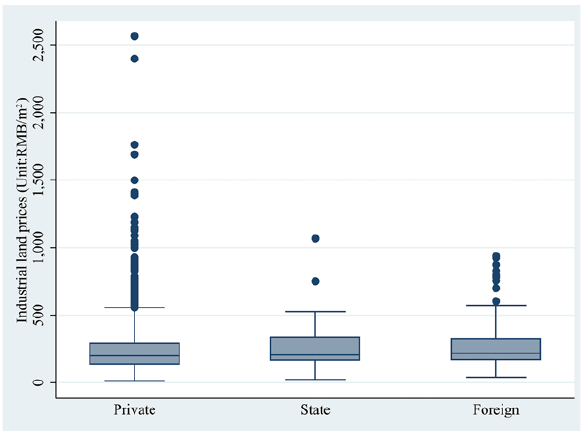
Figure 9. Comparison of industrial land prices by ownership type